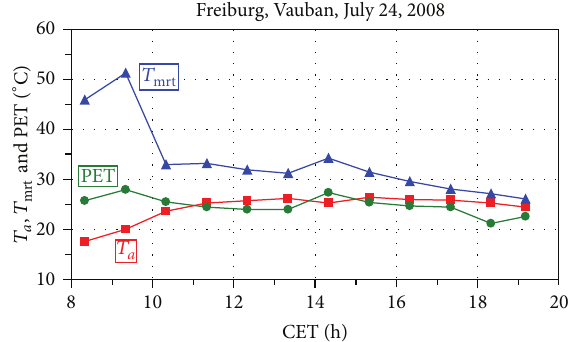
Figure 17: 1h mean values of the short-wave radiant flux densities 𝑖 = down, up, E, S, W, and N) from the three-dimensional 𝐾 𝑖, abs ( environment absorbed by the human-biometeorological reference person, related to the 1h peak value of 𝐾 25 W/m 2 ), SSW-facing sidewalk (shaded by tree canopies) of a WNW-ESE street canyon, “Vauban” quarter in Freiburg during typical Central European summer day.